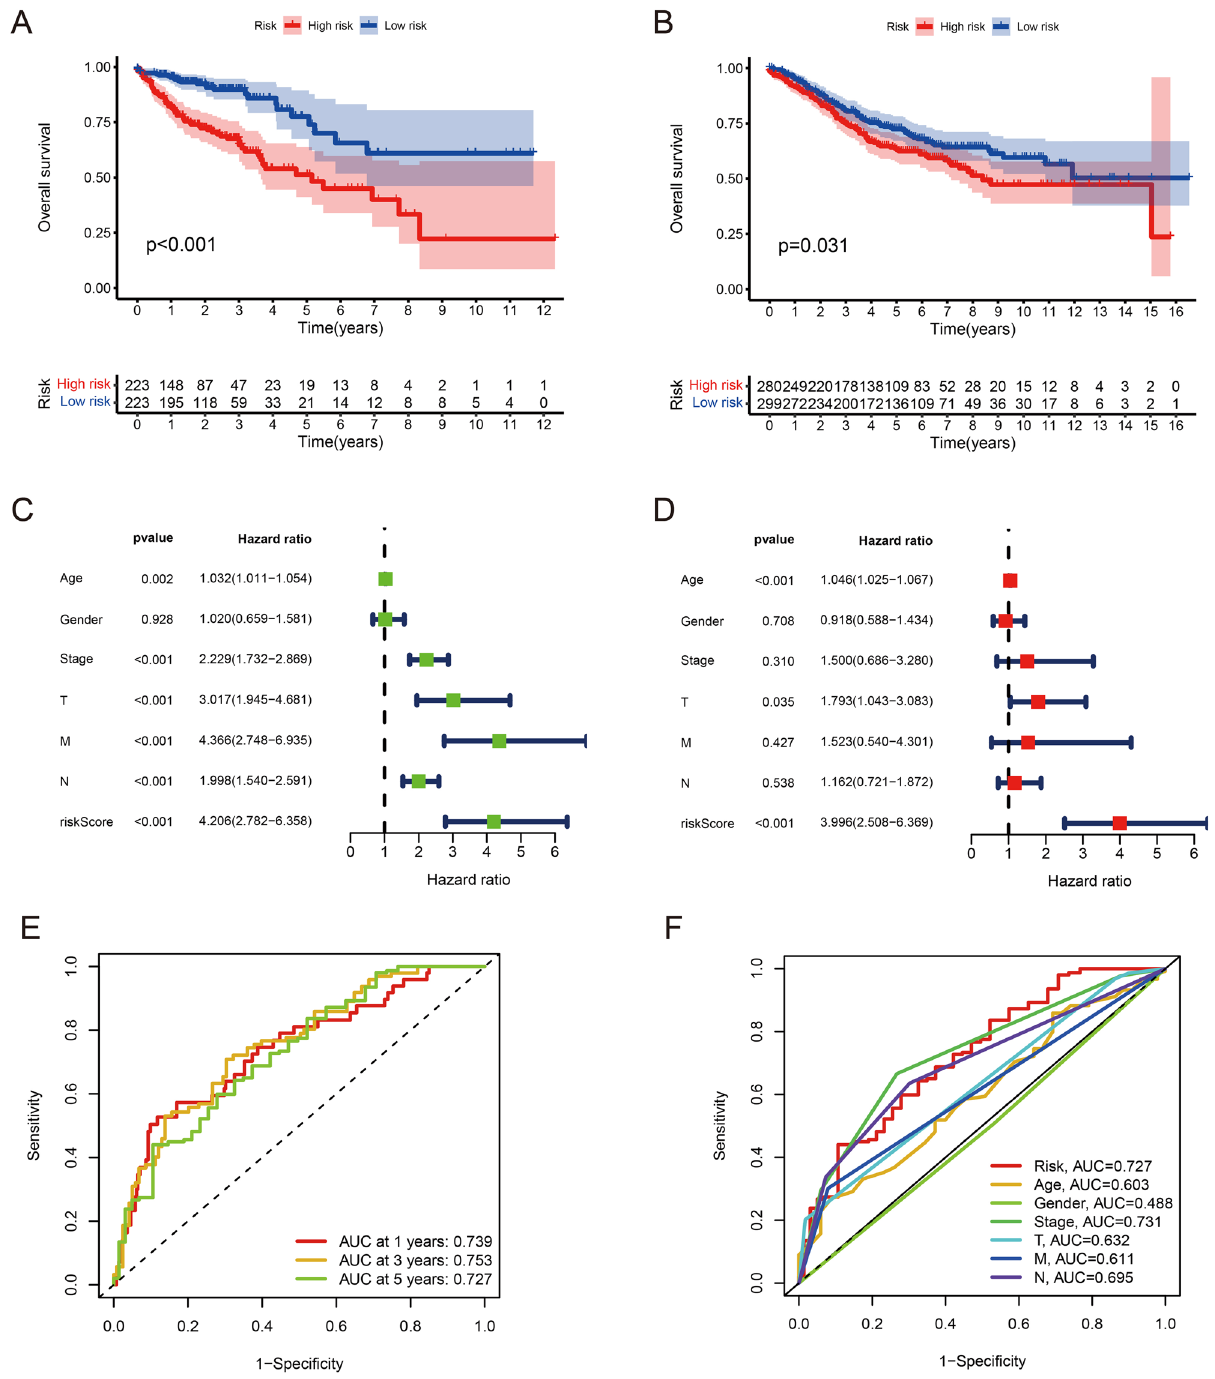
Figure 3. Predictive value of butyrate metabolism risk score in CRC survival. ( A ) Overall survival by butyrate metabolism risk score in the TCGA-CRC cohort. ( B ) Overall survival by butyrate metabolism risk score in the GEO-CRC cohort. ( C ) Results of univariate independent prognostic analysis in the TCGA-CRC cohort. ( D ) Results of multivariate independent prognostic analysis in the TCGA-CRC cohort. ( E ) AUC values at 1, 3, and 5 years in the TCGA-CRC cohort. ( F ) ROC curves of risk scores and clinical characteristics in the TCGA-CRC